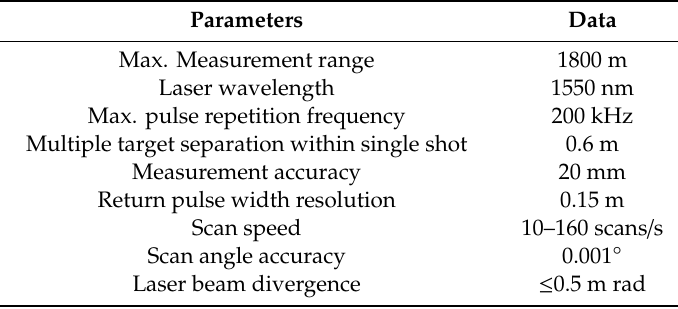
Table 1. The system parameters of RIEGL LMS-Q560.